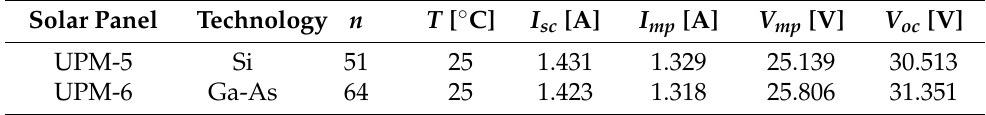
Figure 10. The UPMSat-1 satellite; launched in 1995, this was the tenth university-developed space mission in history [93]. ( a ) Satellite during the integration in the Ariane IV-40 launcher (V75 flight). ( b ) Exploded view drawing. Table 5. Characteristics of the measured I-V curves corresponding to the UPM-5 and UPM-6 solar panels of UPMSat-1 (see Figure 10).